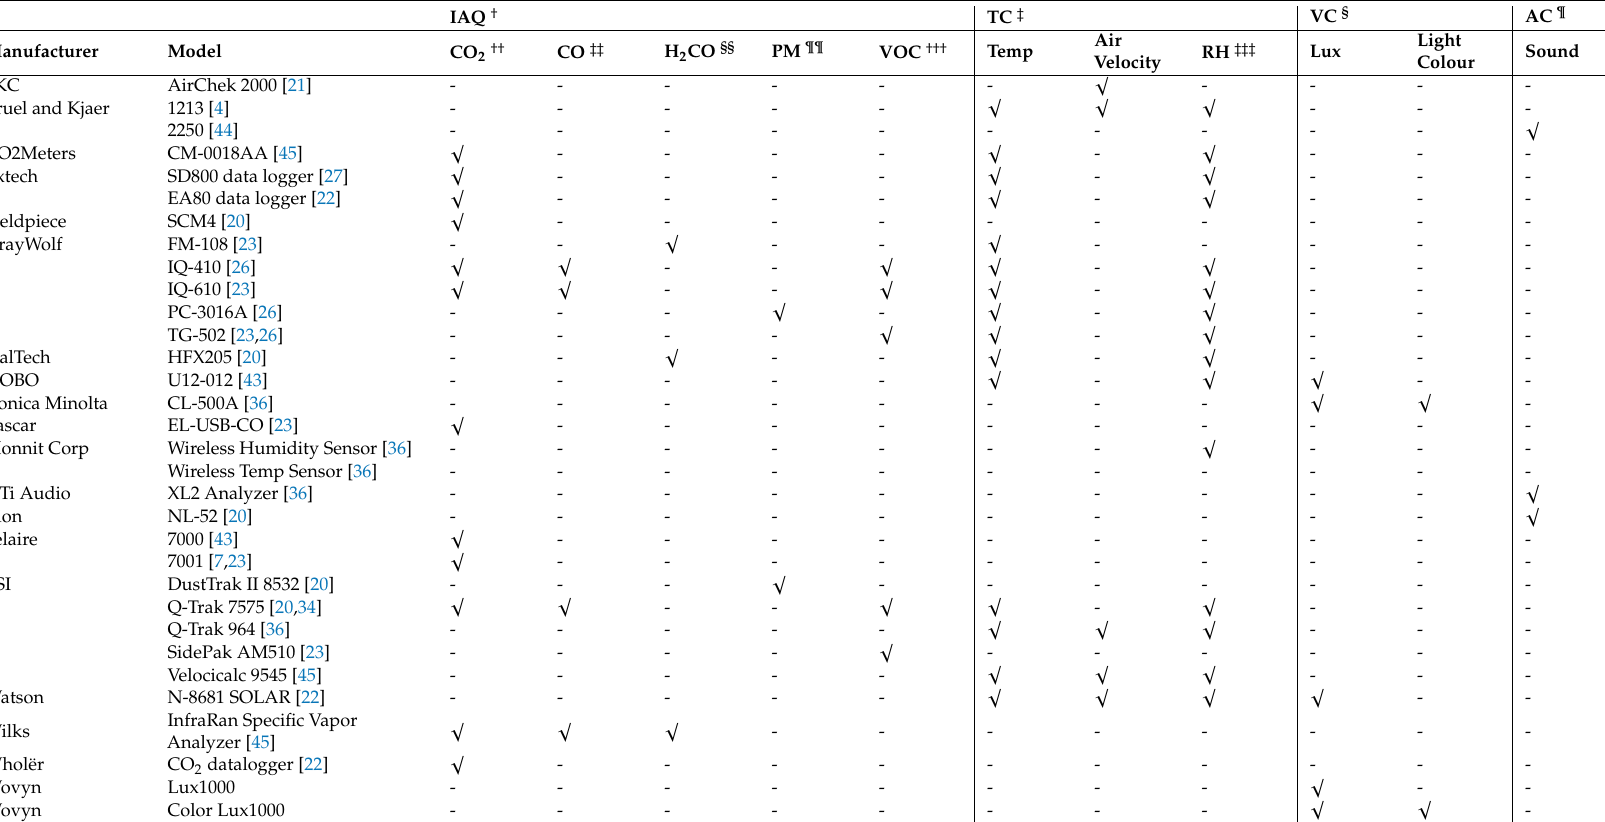
Table outlines state-of-the-art sensors used within reviewed studies, outlining the manufacturers, models and measurement, factors. These sensors cost range from several hundreds of pounds to several thousand. † Indoor Air Quality. ‡ Thermal Comfort. § Visual Comfort. ¶ Acoustic Comfort. †† Carbon Dioxide. ‡‡ Carbon Monoxide. §§ Formaldehyde. ¶¶ Particulate Matter (PM1.0 / PM2.4 / PM10). ††† Volatile Organic Compounds. ‡‡‡ Relative